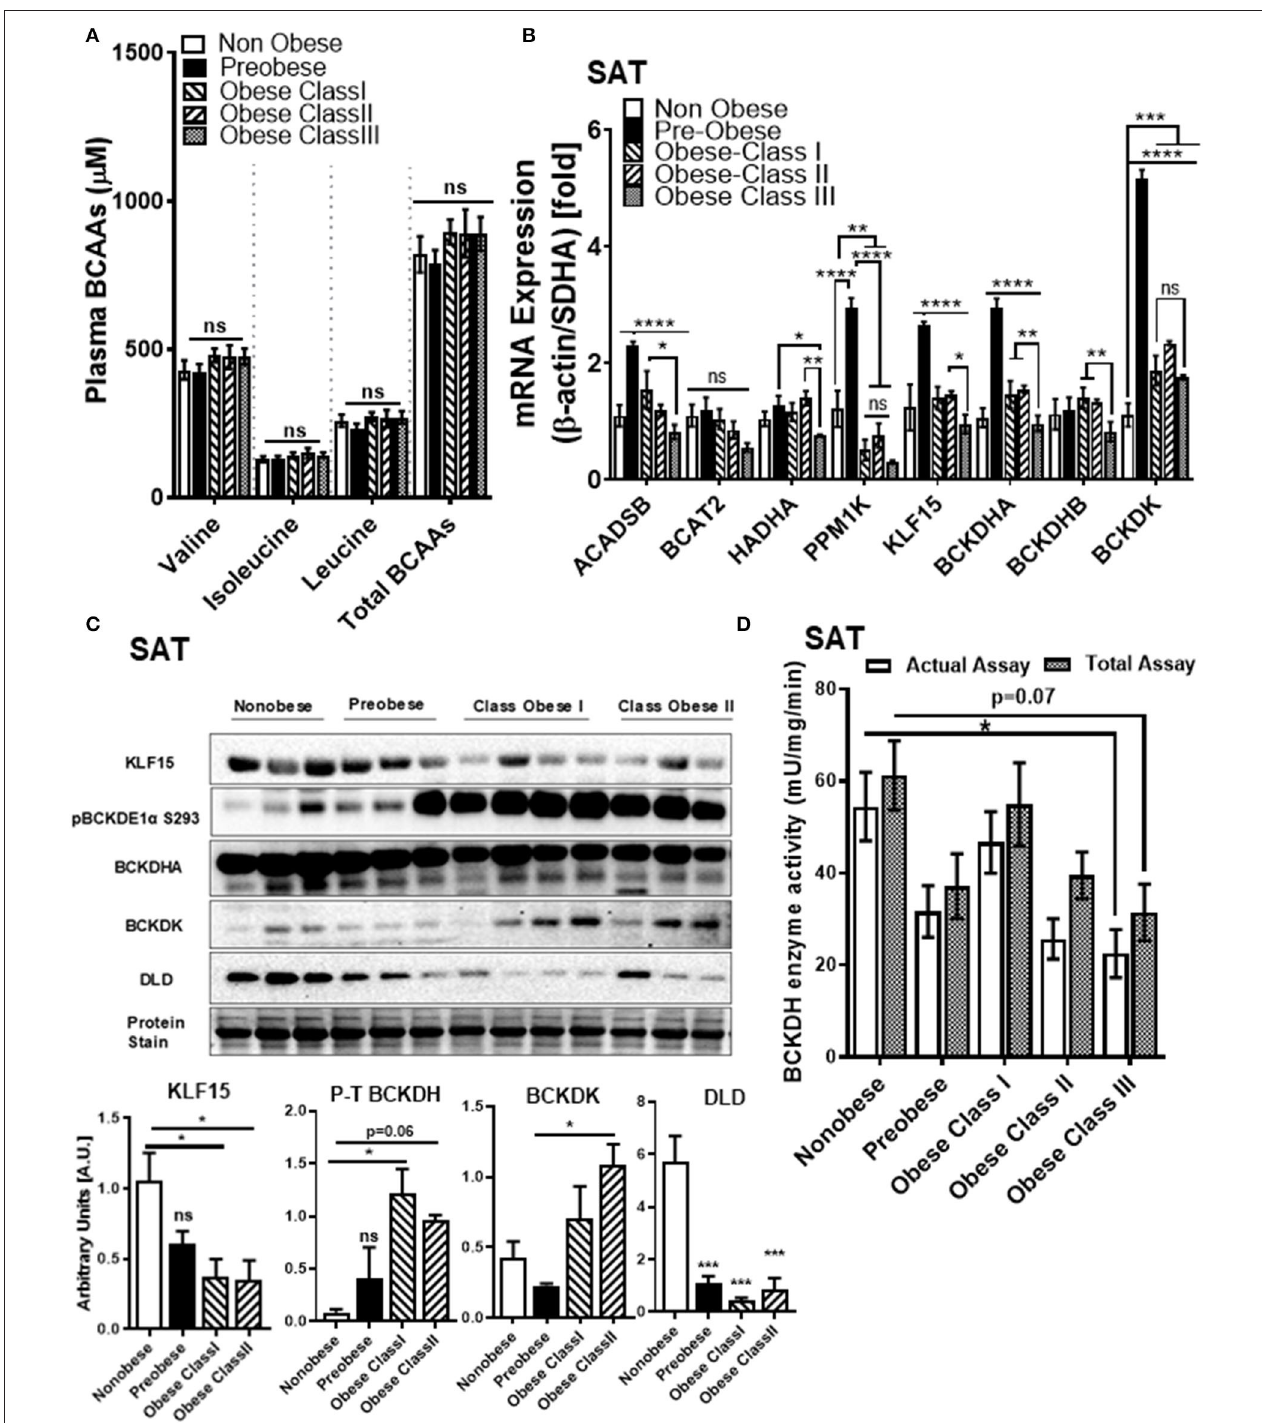
FIGURE 2 | BCAA catabolic enzyme expression and BCKDH enzyme activity is decreased in the SAT of cardiac surgery patients with severe obesity. (A) Free plasma BCAA levels measured by UPLC MSMS in the non-obese ( n = 8), pre-obese ( n = 6) and class I obese ( n = 7), class II obese ( n = 6) and class III obese ( n = 6) cardiac surgery patients. (B) Quantification of ACADSB, BCAT2,HADHA, PPM1K, KLF15, BCKDHA, BCKDHB, and BCKDK mRNA expression corrected to β -actin and SDHA (39) and expressed as fold change in the SAT of non-obese ( n = 6), pre-obese ( n = 6) and obese class I ( n = 6), class II ( n = 6) and class III ( n = 6) cardiac surgery patients. (C) Representative immunoblot and densitometric analysis of KLF15, pBCKDE1a, BCKDH, BCKDK, and DLD protein levels in the SAT of non-obese ( n = 3), pre-obese ( n = 3), class I obese ( n = 4) and class II obese ( n = 3) cardiac surgery patients. (D) Total and actual BCKDH enzyme activity corrected to protein levels, measured at Vmax ( t = 15min) in the SAT of non-obese ( n = 7), pre-obese ( n = 9), class I obese ( n = 9), class II obese ( n = 9) and class III obese ( n = 8). Statistical analysis was performed using a two-way ANOVA followed by a Tukey’s multiple comparison test; * p < 0.05, ** p < 0.01, *** p < 0.001, **** p < 0.0001 as indicated